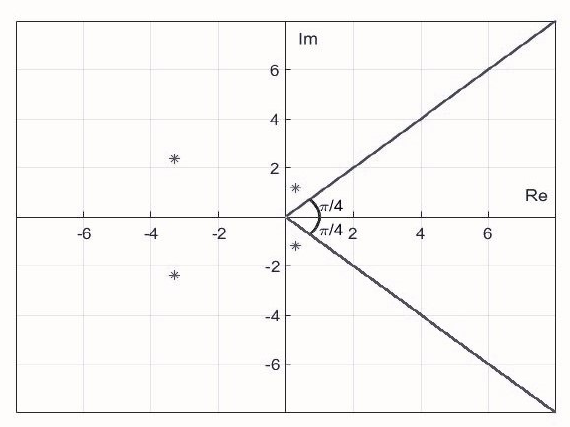
Figure 3. Roots of the characteristic equation √ in q = s